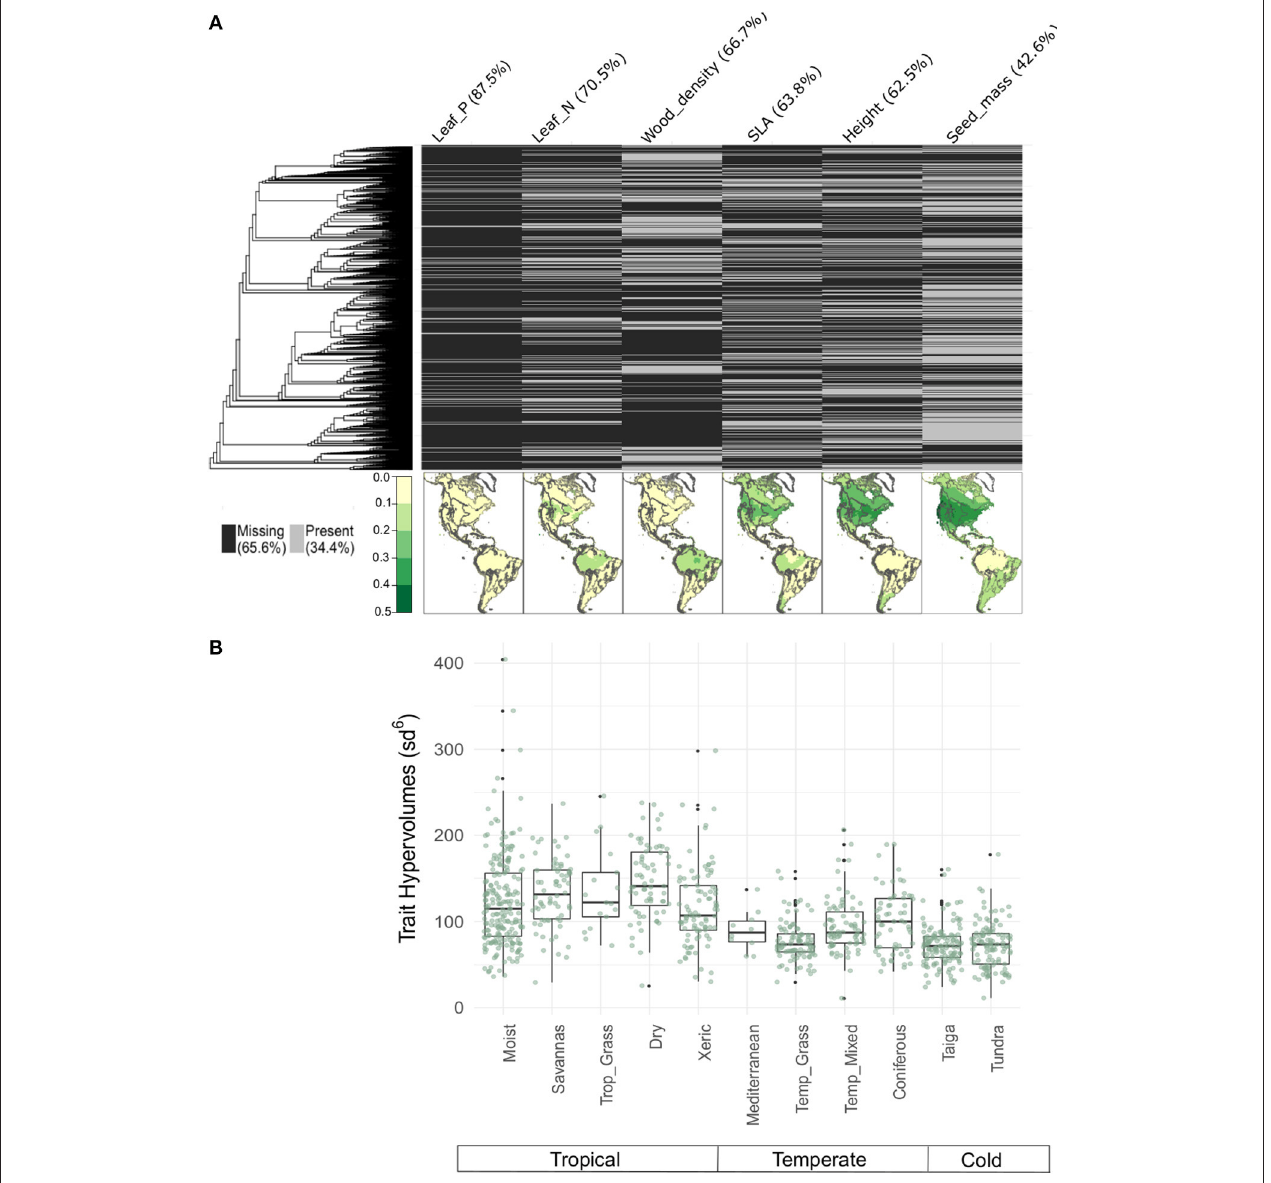
FIGURE 2 | (A) Proportion of species in the BIEN 3.0 database with known (gray) or missing (black) trait values. Phylogeny at the left corresponds to the seed plants ALLBM tree from Smith and Brown (2018) (i.e., GenBank and Open Tree of life taxa with a backbone provided by Magallón et al., 2015). Maps represent the proportion of species with trait information relative to the total number of species in the BIEN 2.0 database. (B) Distribution of trait hypervolumes of 20% of randomly selected 100 × 100km cells in each biome. Hypervolumes are reported in units of standard deviations to the power of the number of traits